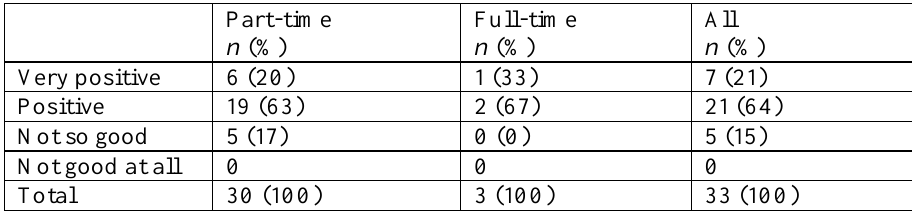
Level of Satisfaction Overall Based on Type of Registration